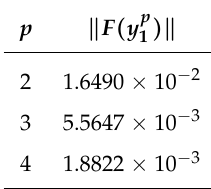
Table 2. Proximity of the first step of iterative methods (10) to the solution of integral Equation (15), for different values of p .